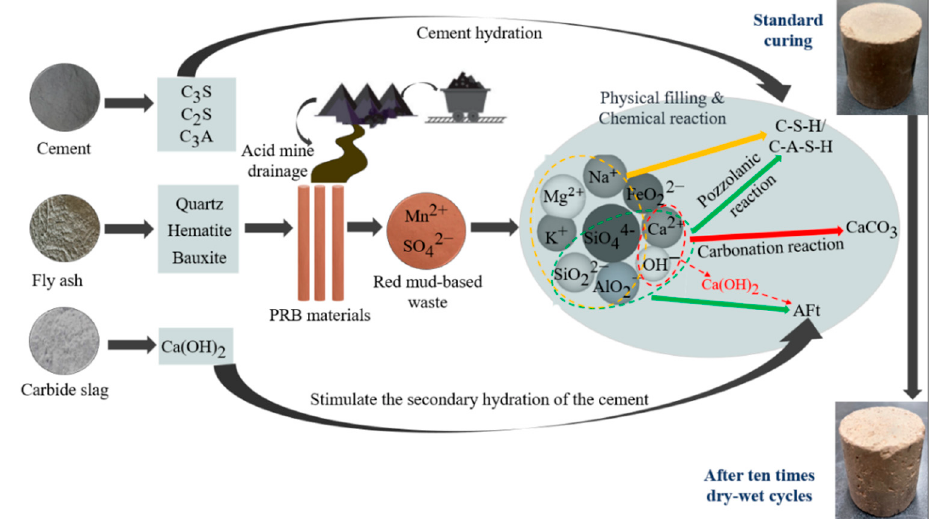
Figure 14. Schematic diagram of the mechanism.